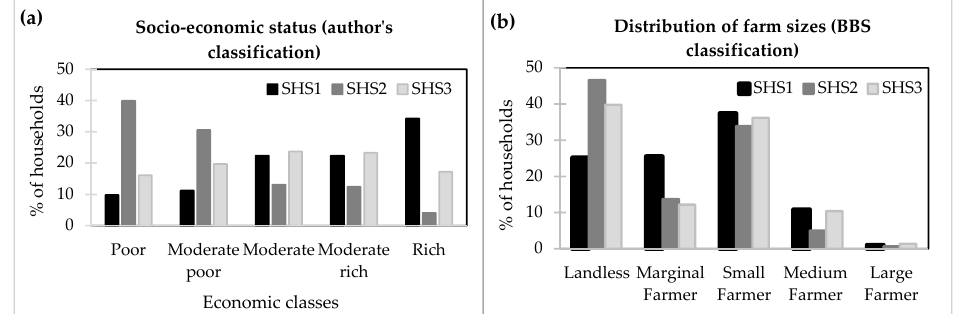
Figure 4. Current socio-economic status of the households in the study area by socio-hydrological space. ( a ) Socio-economic status (author’s classification); ( b ) Distribution of farm sizes (BBS classification).